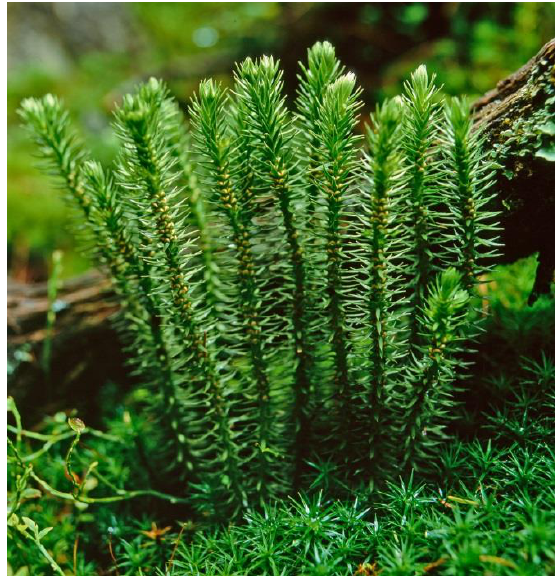
Figure 1. Fir clubmoss ( Huperzia selago ) sporophyte in its natural habitat in the Babia Góra National Park, Poland. Side view of the H. selago shoots presenting distribution of sporangia.